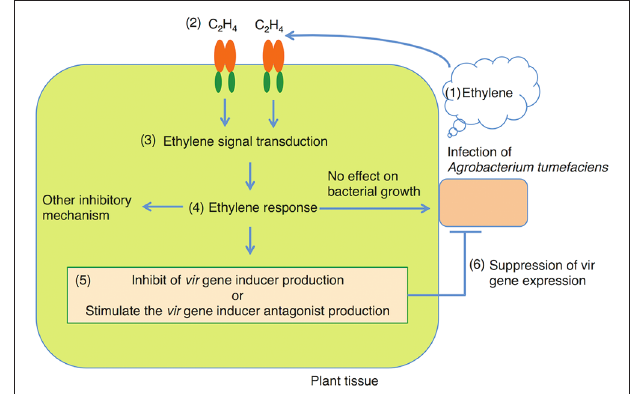
FIGURE 1 | Schematic drawing of the potential mechanisms of inhibition through ethylene signaling and vir gene expression. (1) The infection of A. tumefaciens induces ethylene evolution from plant tissue. (2) Ethylene is received by the ethylene receptor. (3) Ethylene signal transduction is induced and, (4) subsequently, the plant shows the ethylene response. (5) In plants that show the ethylene response, vir gene inducer production would be suppressed or an antagonist of the inducer would be produced, (6) resulting in a reduction of vir gene expression in A.